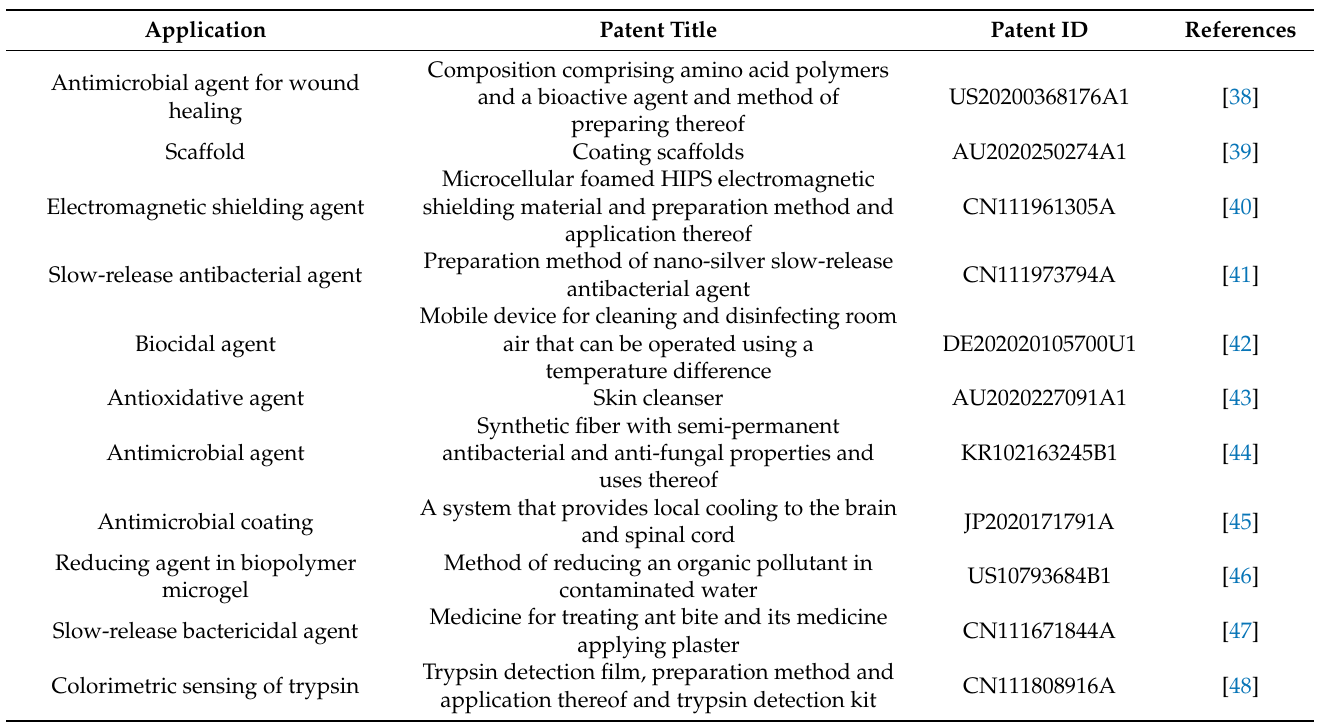
Table 2. Recent patents related to silver